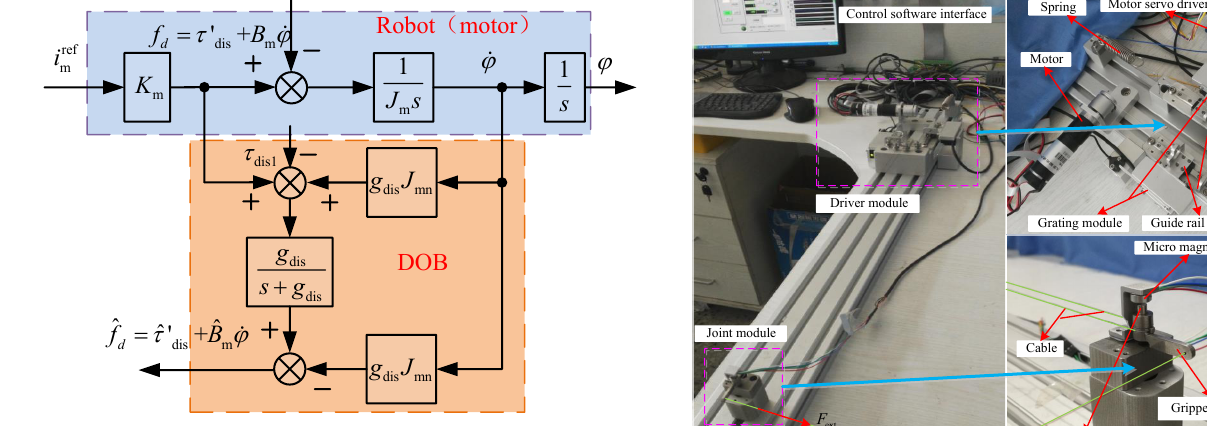
Figure 5. The basic block diagram of DOB.